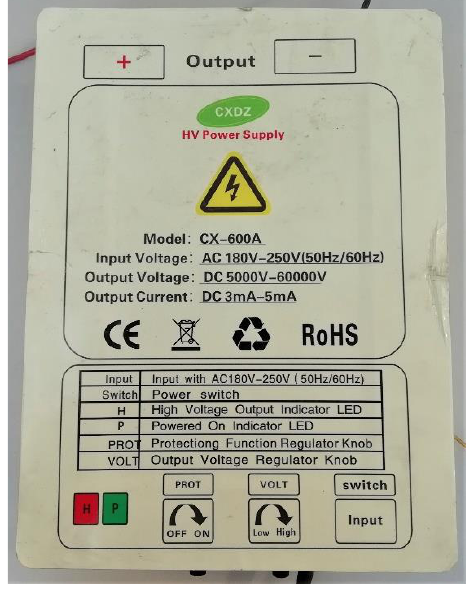
Figure 3. DC power